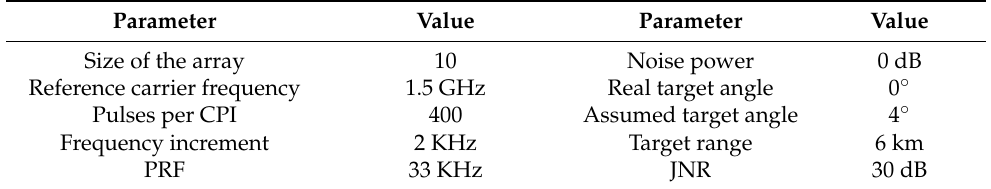
Table 1. Simulation